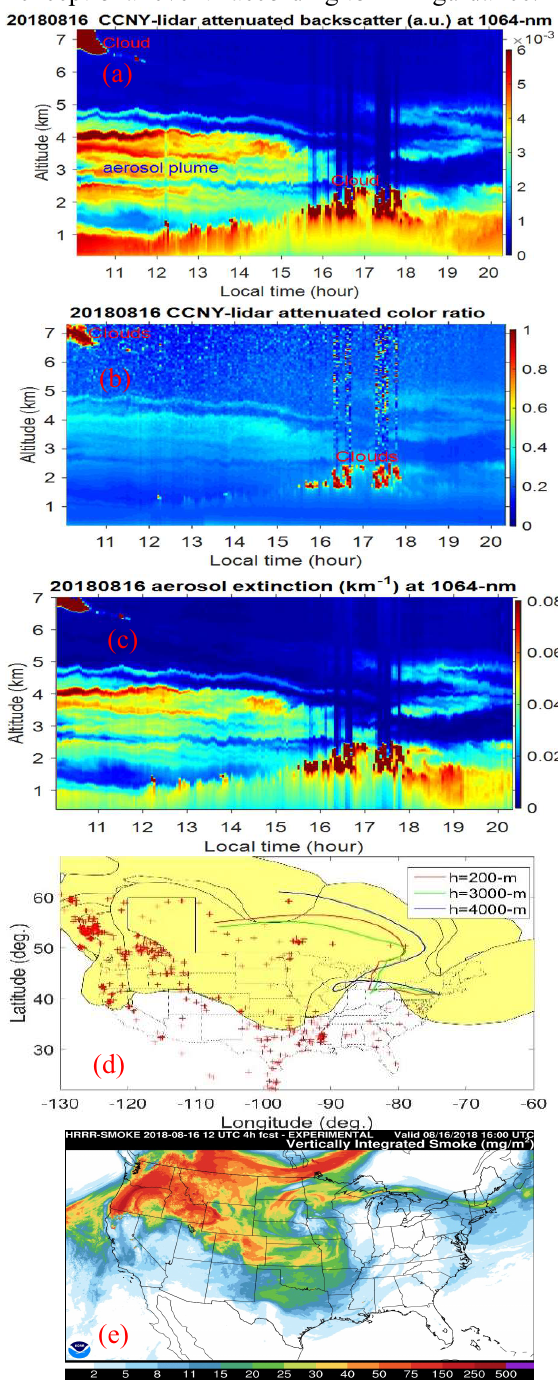
Fig. (cid:21) (a)-(c) CCNY-lidar attenuated backscatter, color- ratio, aerosol extinction (S 1064 =55-sr), (d)-(e) NOAA- HYSPLIT backward trajectory, HMS fire points (red+)- smoke (yellow), HRRR model smoke on Aug.16,